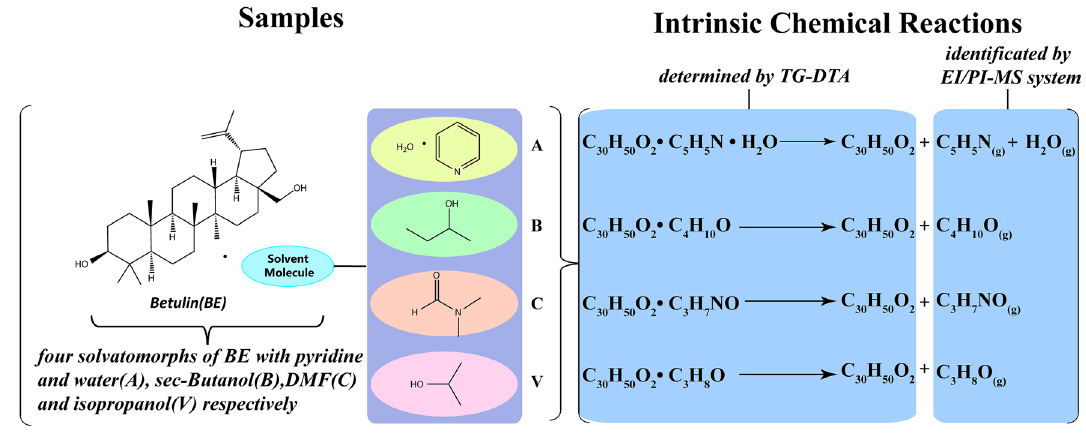
Fig. 2 Mechanism of analysis on the four solvatomorphs of BE by the TG–DTA–EI/PI–MS system Equipped with the skimmer-type